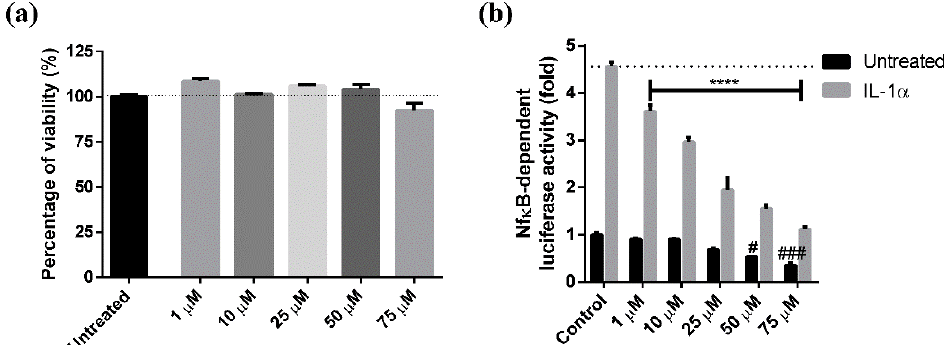
Figure 6. Dose-dependent effect of rosiglitazone used as reference active compound on R3/1-NF- κB cells ( a ) viability (MTT assay) and ( b ) IL-1α induced NF-κB activation. Data are reported as mean ± SEM. The statistical significance difference of each concentration in respect to the control was analyzed by ONE-WAY analysis followed by the Bonferroni post-test. For the untreated series: # p < 0.05, ### p < 0.001. For IL-1α treated samples: **** p < 0.0001.